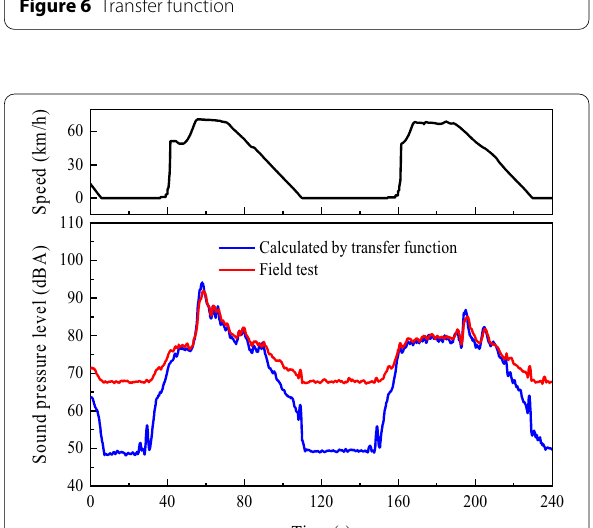
Figure 6 Transfer function